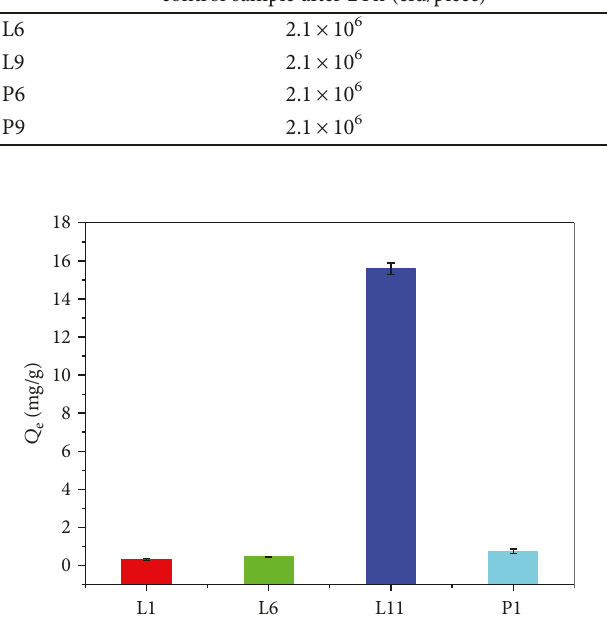
The average recovery of bacteria for blank Sample control sample after 24 h (cfu/piece)